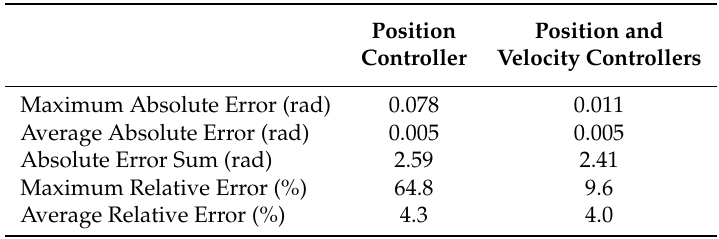
Table 5. Steady-State Position Errors